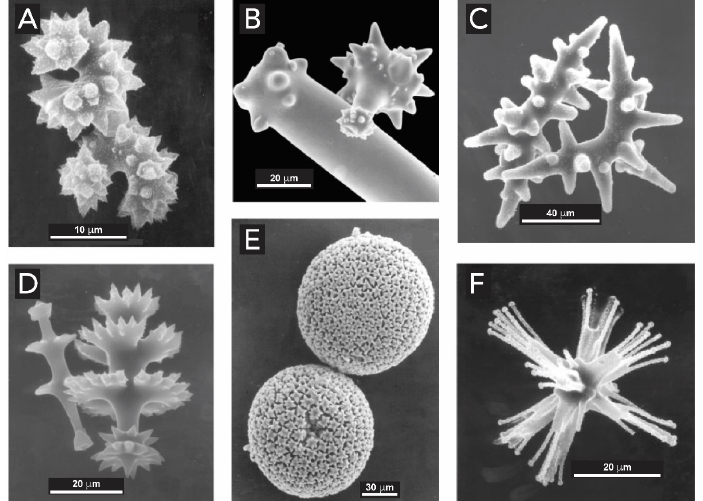
Figure 11. Scanning Electron Microscopy (SEM) images of spicules from different orders of Demospongiae and Hexactinellida sponges. ( A ) Spirasters of Spirastrella . ( B ) Asterose microacanthostyle of Discorhabdella . ( C ) Microscleres of Paradesmanthus . ( D ) Discorhabds of Latrunculia . ( E ) Sterrasters of Geodia . ( F ) Floricome (microhexaster) of Sympagella . (Spirasters: a short curved axial rod-like spicule with thick spines. Asterose: small star-shaped spicules. Microsclere: a flesh-spicule of a sponge, usually found as the support of a single cell. Discorhabds: a monaxial straight rhabd (rod-shape) with one sharp and one blunt end and girdled with concentric rings. Sterrasters: ball-shaped spicules. Floricome: branched hexaster spicules.) Reproduced from [87] with permission from John Wiley and Sons.